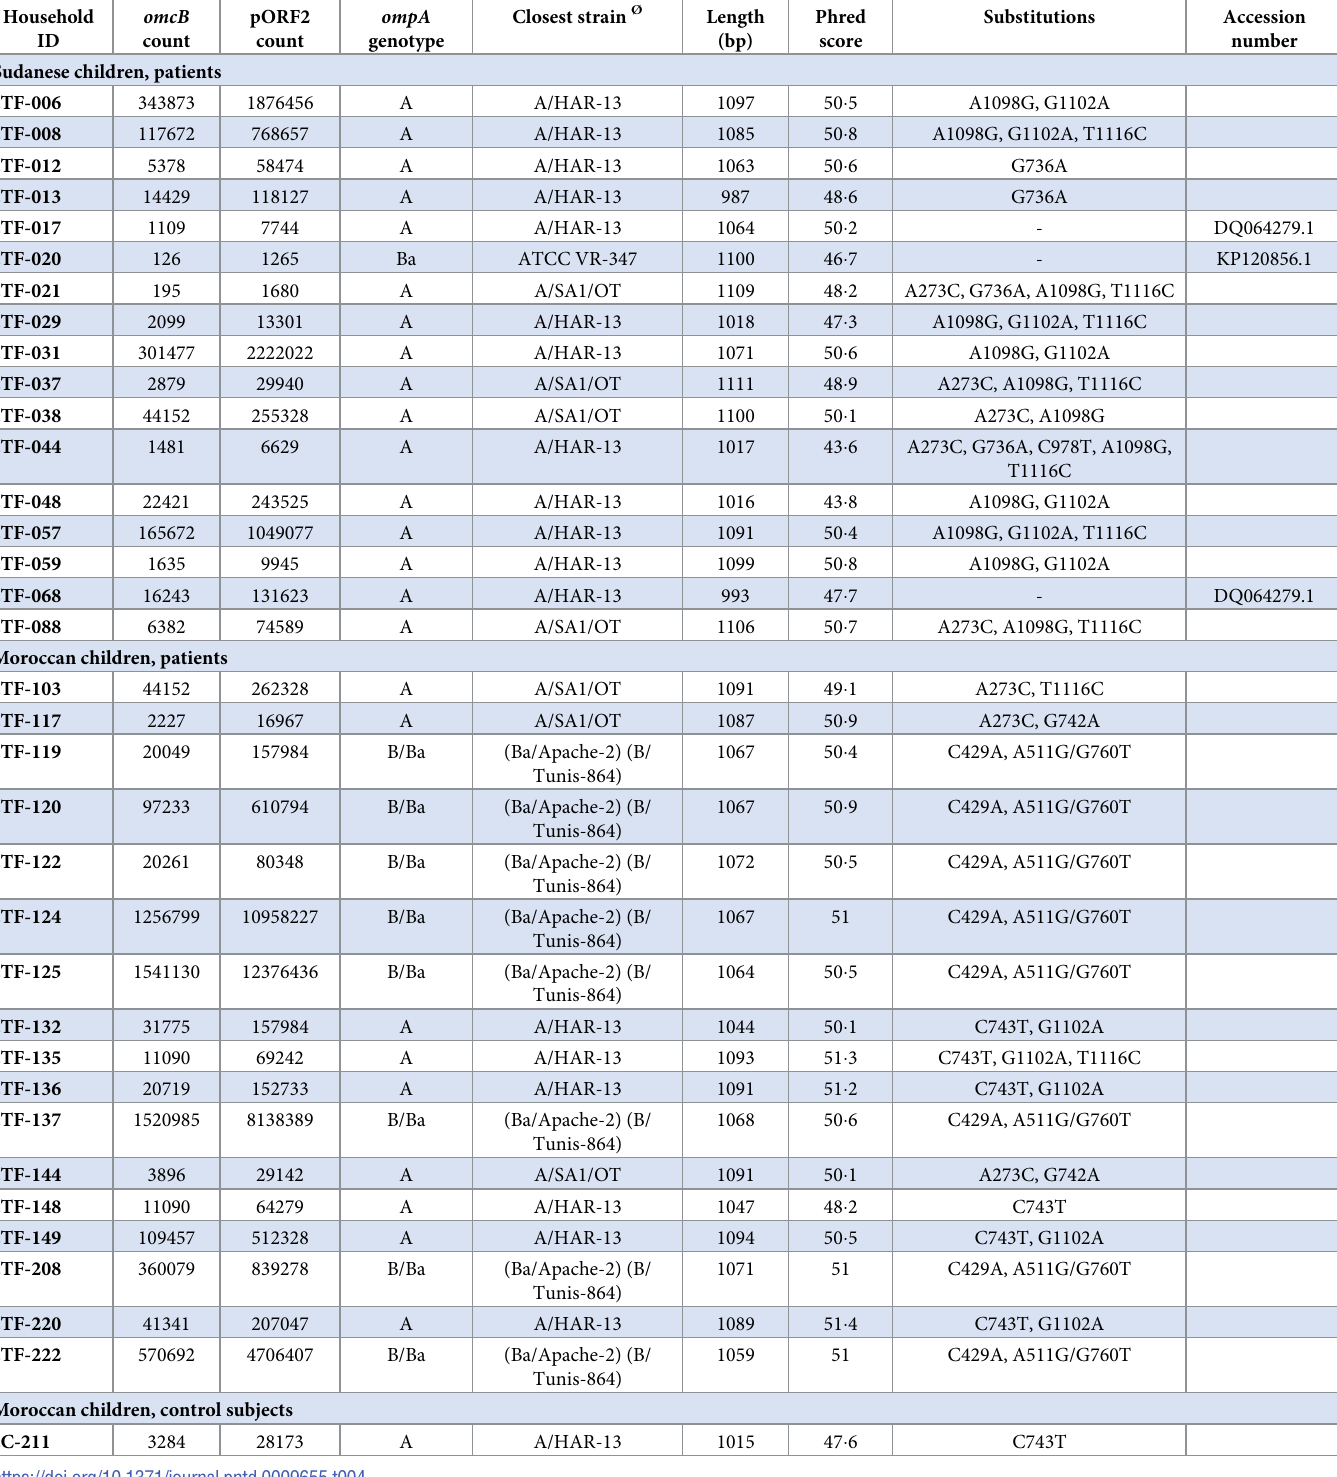
Table 4. General profiles of omcB and plasmid copy numbers and BLAST-n analysis of the ompA gene for each Ct-positive